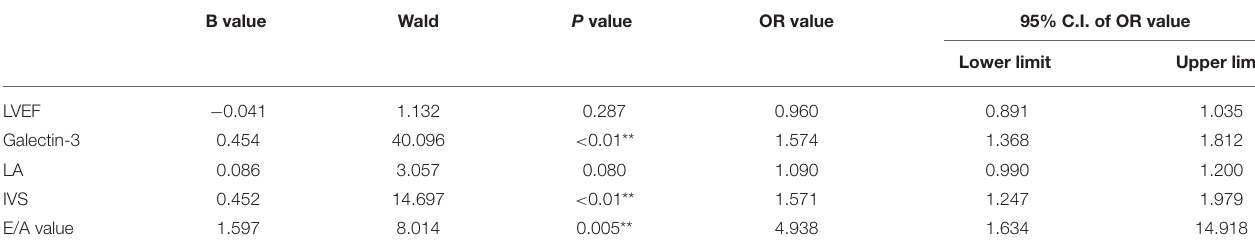
TABLE 2 | Logistic regression analysis.